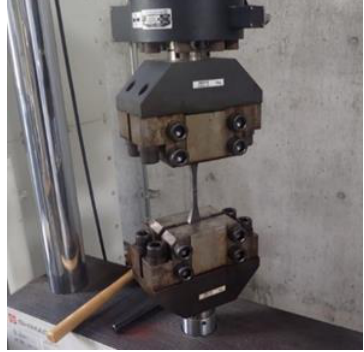
Figure 14. Photo of fatigue test.